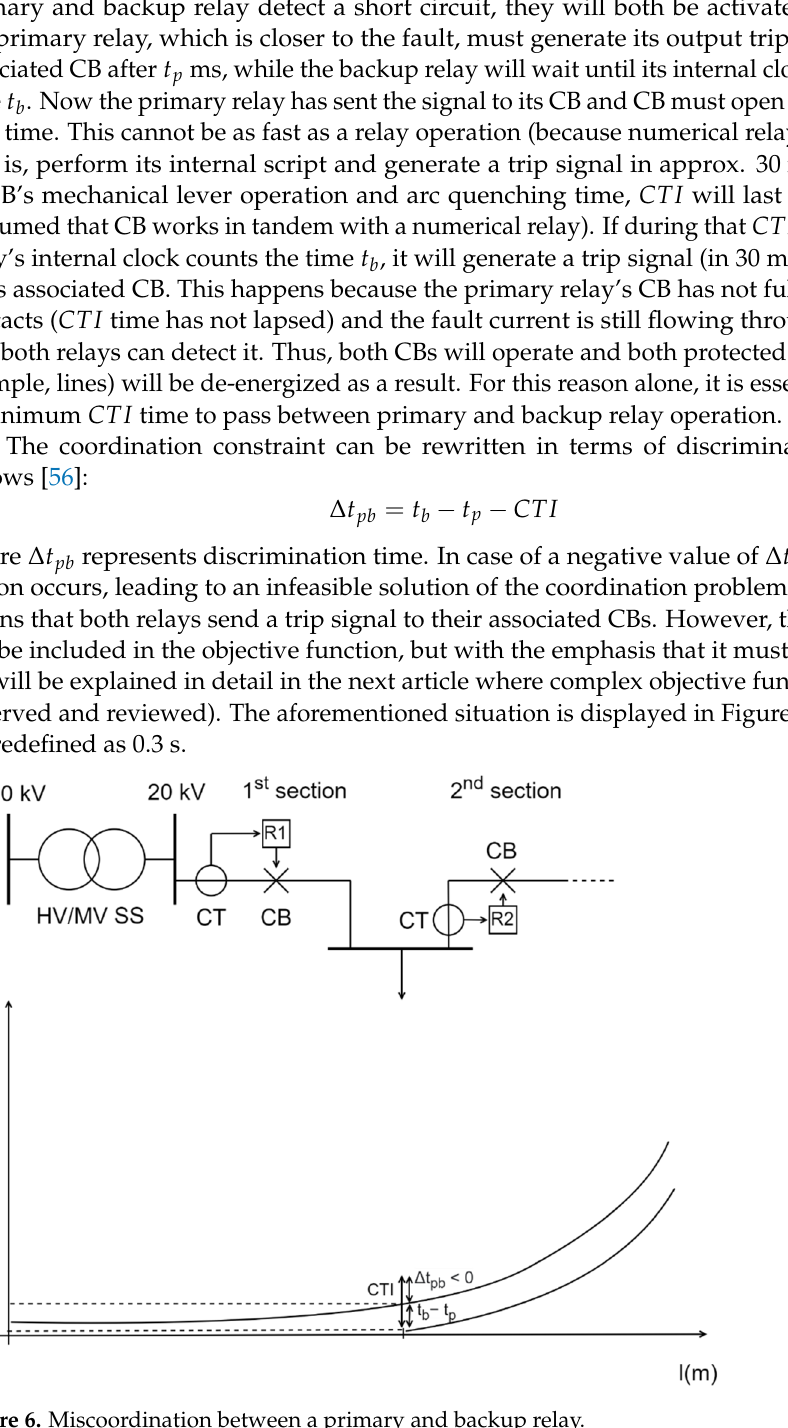
Figure 6. Miscoordination between a primary and backup